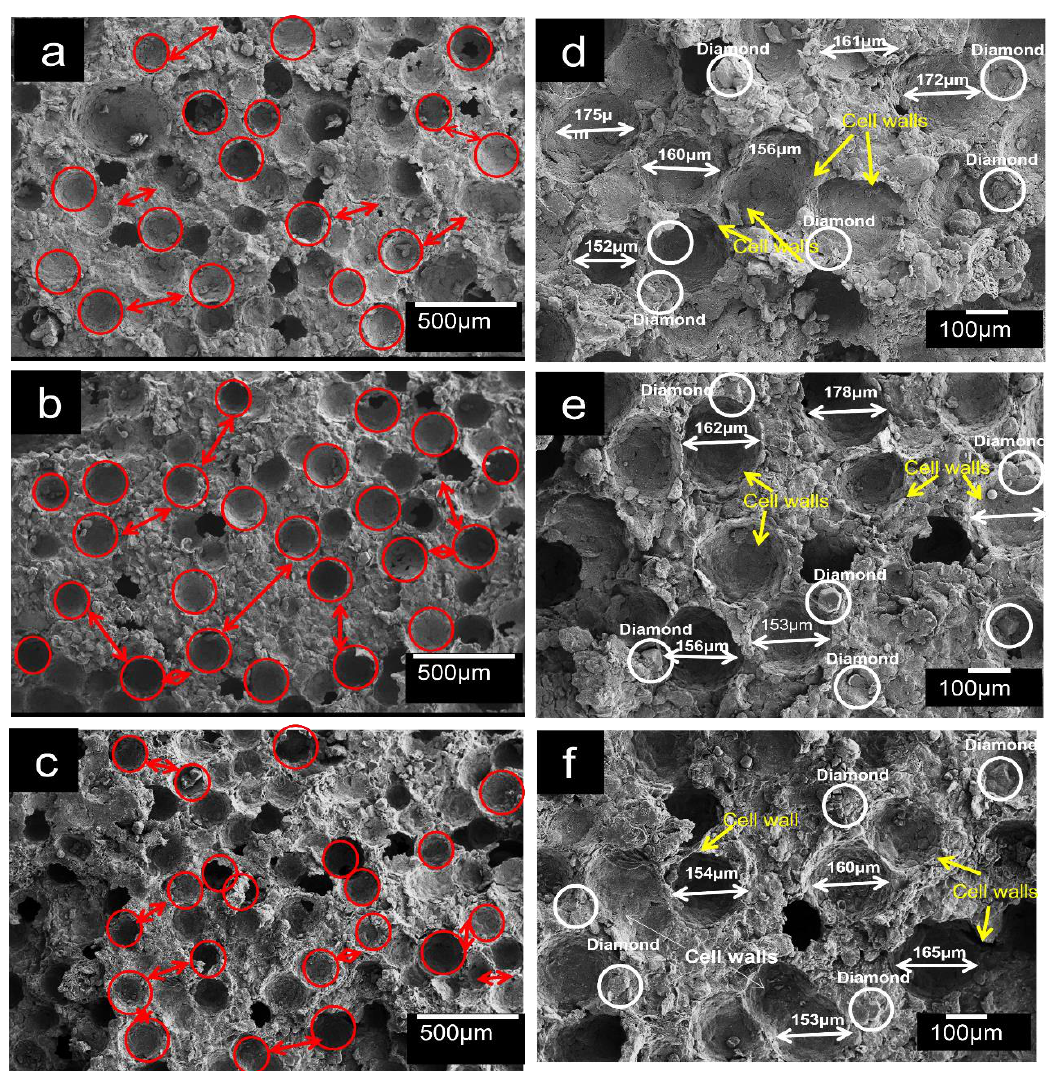
Figure 3. SEM morphology of porous Al composites developed at, ( a , d ) 580 °C, 350 MPa, and 60 min, ( b , e ) 590 °C, 350 MPa, and 120 min, and ( c , f ) 600 °C, 350 MPa, and 120 min.